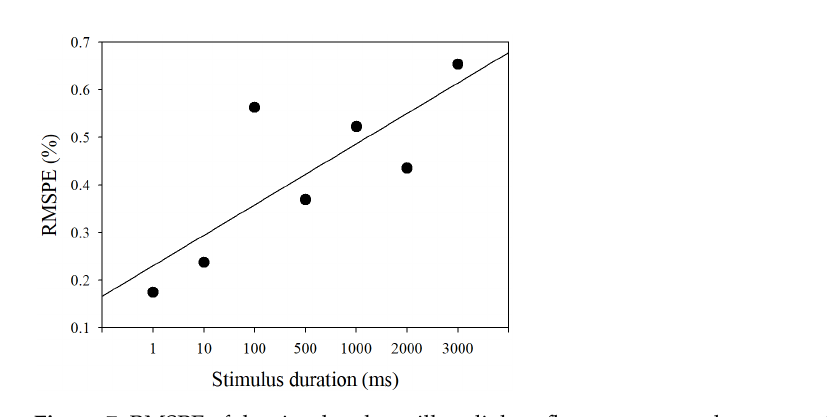
Figure 6. Measured pupillary light reflex (PLR) response and simulated PLR response. The circle markers are measured PLR response, and the solid lines are simulated PLR response.